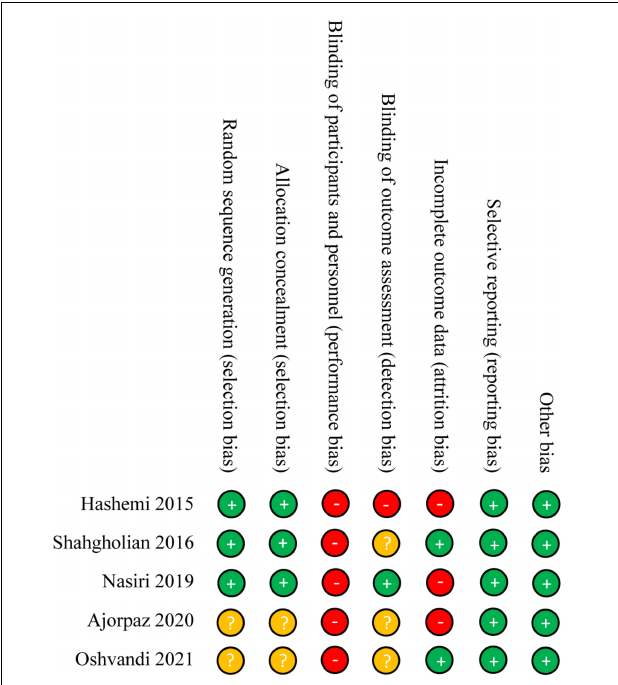
FIGURE 2 | Risk of bias summary of each eligible